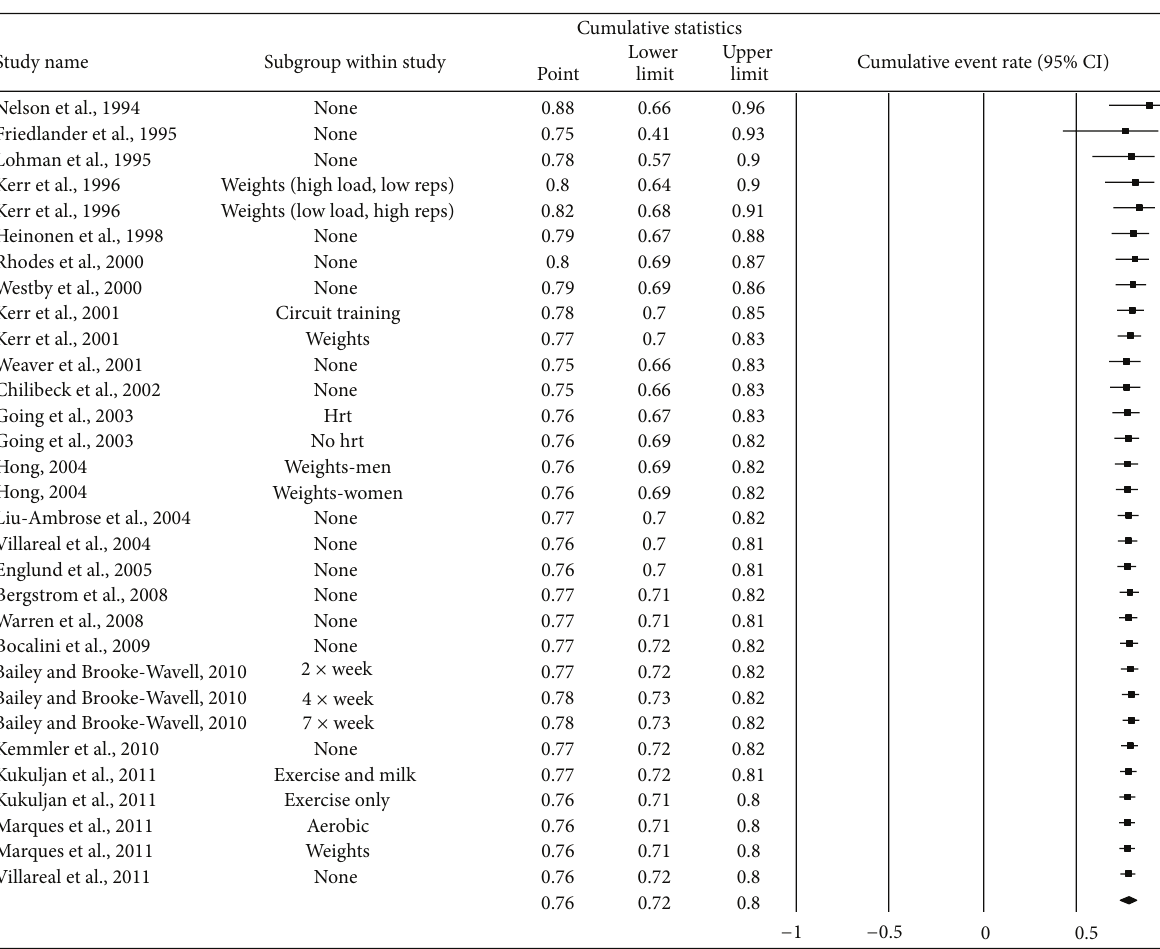
Figure 12: Cumulative meta-analysis for compliance. Cumulative meta-analysis, ordered by year, for compliance. The black squares represent the event rate for each group from each study along with their 95% confidence intervals. The results of each corresponding group are pooled with all studies preceding it. The middle of the black diamond represents the overall mean event rate while the left and right extremes of the diamond represent the corresponding 95% confidence